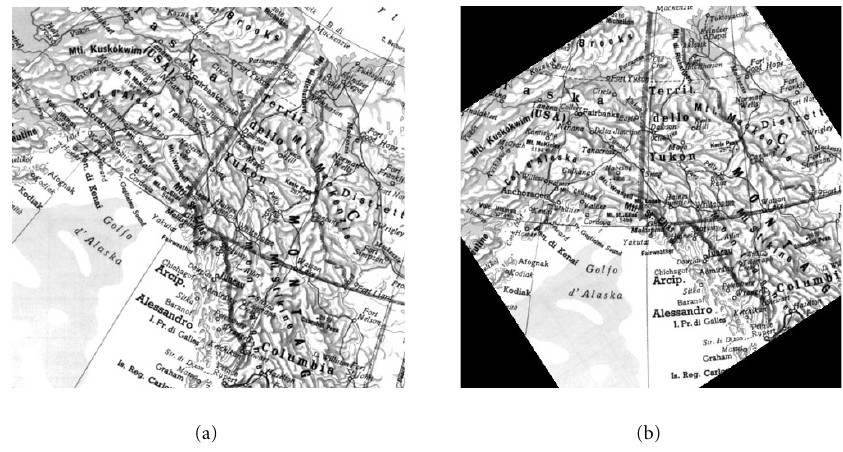
Figure 8: Angle normalization of a map containing letters with different orientation. (a) Original image and (b) normalized image. The normalized image was clipped and scaled for sake of readability.